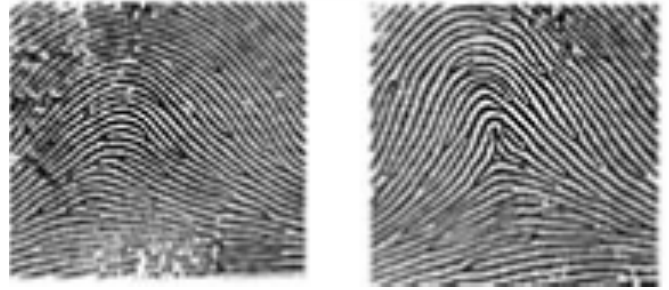
Figure 3. Example type of fingerprint is arch.